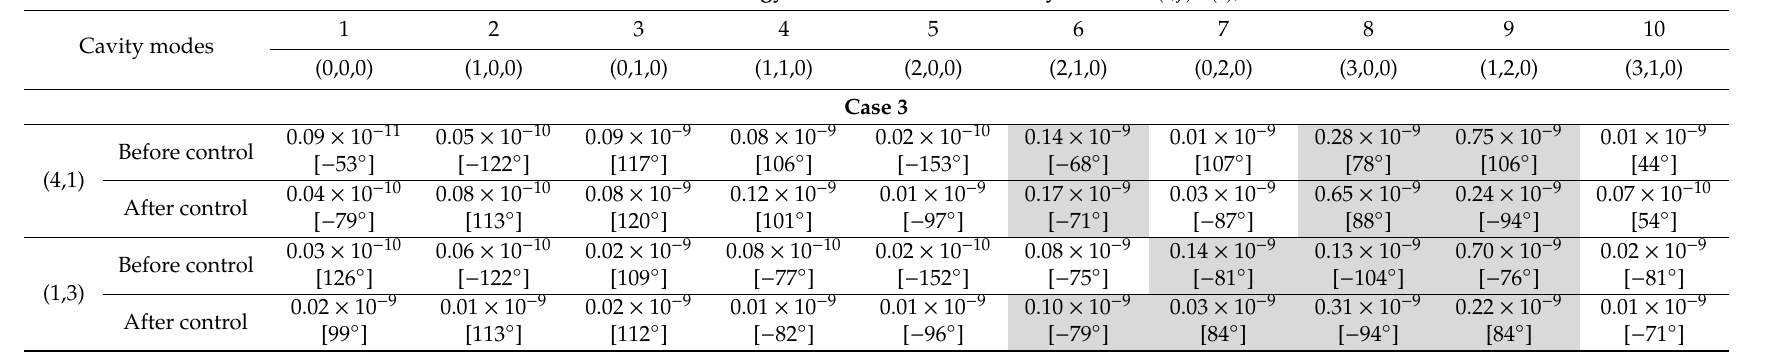
The Energy Contributions from Cavity Modes ( z ( i , j ) P ( i ) , Unit: